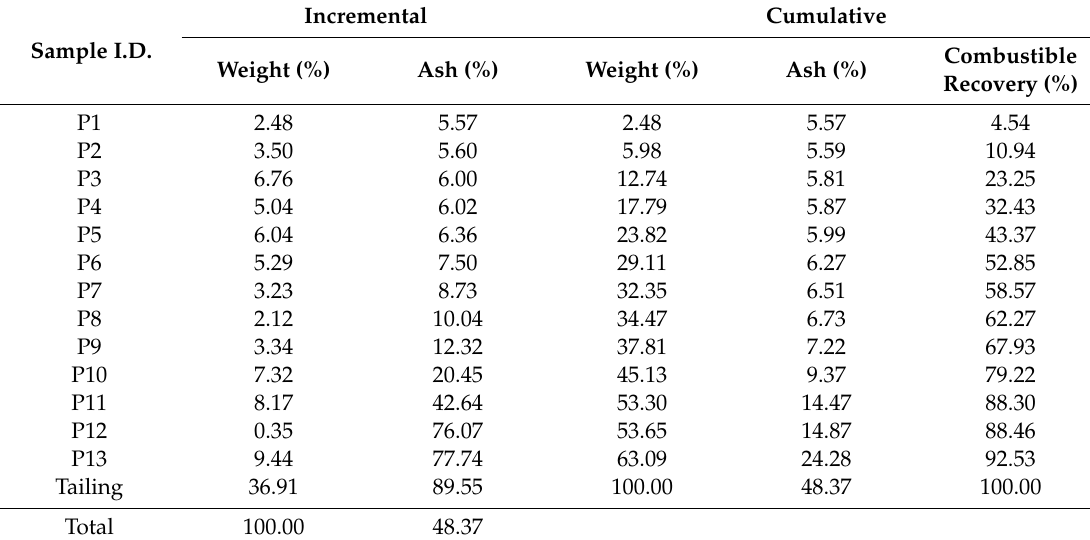
Table 2. Release analysis results for ultrafine Lower Kittanning